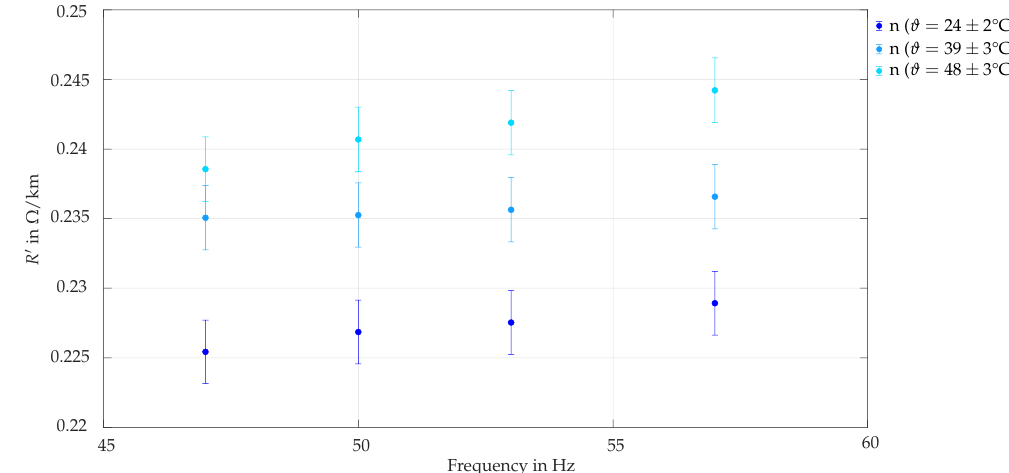
Figure 14. Measured resistances at different temperatures (NAYY-J 4 × 150 SE, cable A